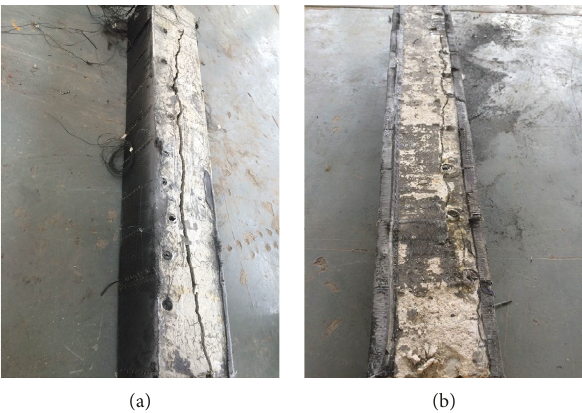
Figure 6: Pullout test under strong constraint condition: (a) failure mode under single load; (b) failure mode under cyclic